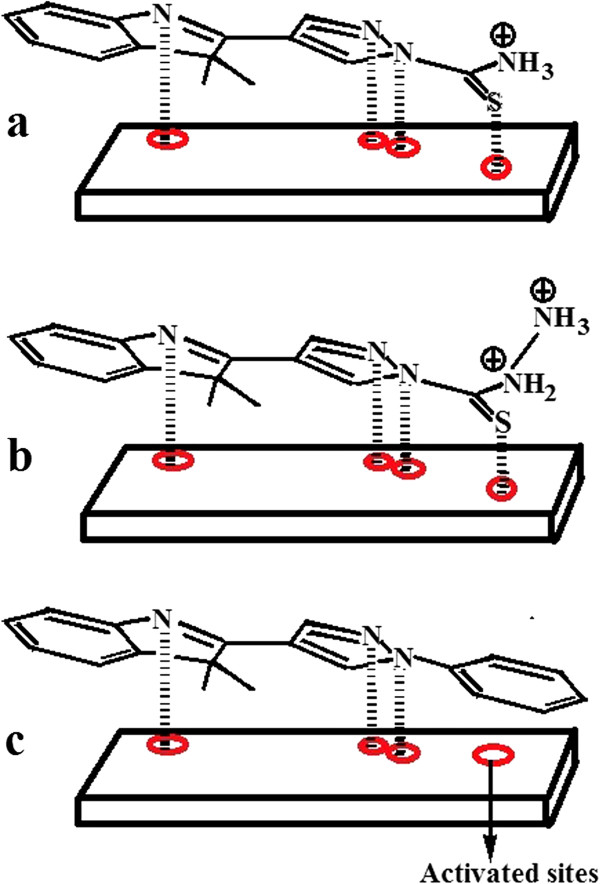
A schematic model for the adsorption of a): InPzTAm, b): InPzTH, c): InPzPh on copper surface.